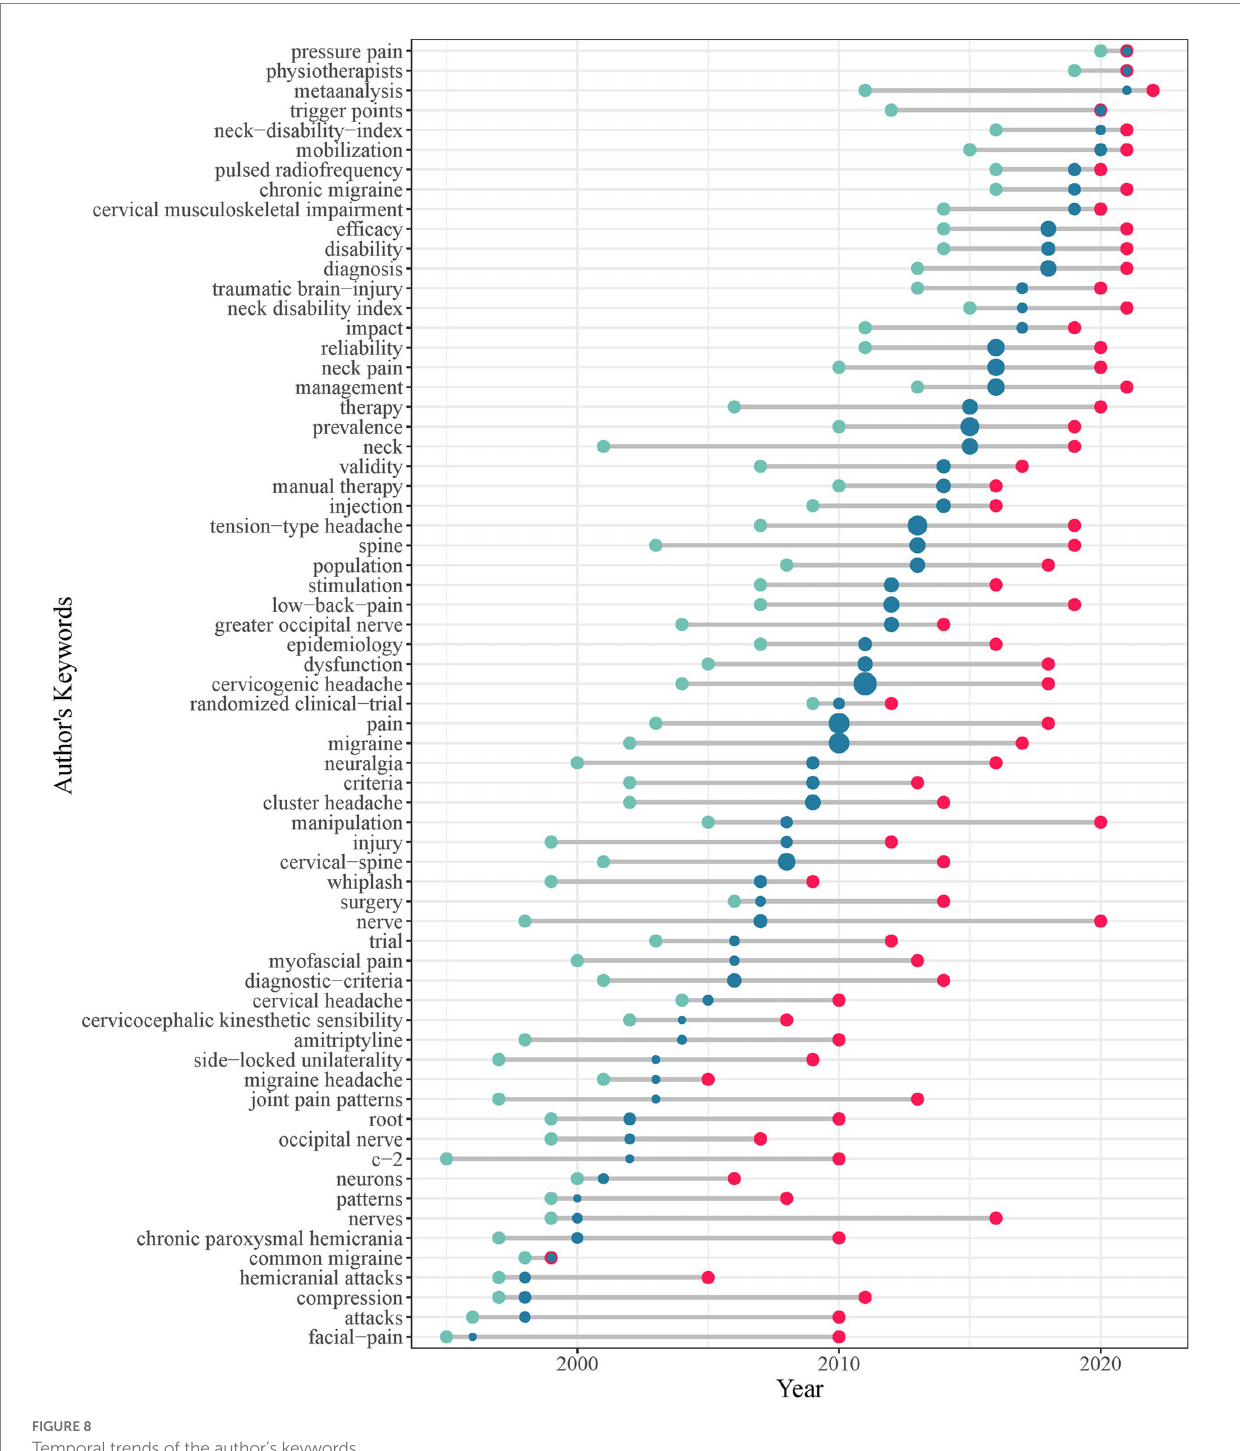
FIGURE 8 Temporal trends of the author’s